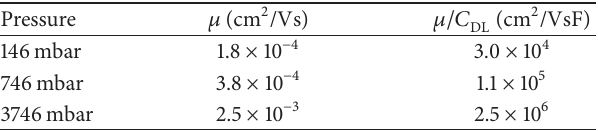
Figure 2: Experimental Nyquist curves obtained for devices with ITO/P3HT:PCBM/Al structure, with the P3HT:PCBM blend pre- pared from a precursor solution based on chlorobenzene, spin- coated at different pressures. Symbol curves represent experimental data and solid curves represent the theoretical fit. Table 1: Values of mobility estimated from IS measurements carried out on ITO/P3HT:PCBM/Al structures applying a 0.3 V reverse bias, with P3HT:PCBM films prepared at different pressures using chlorobenzene as solvent.